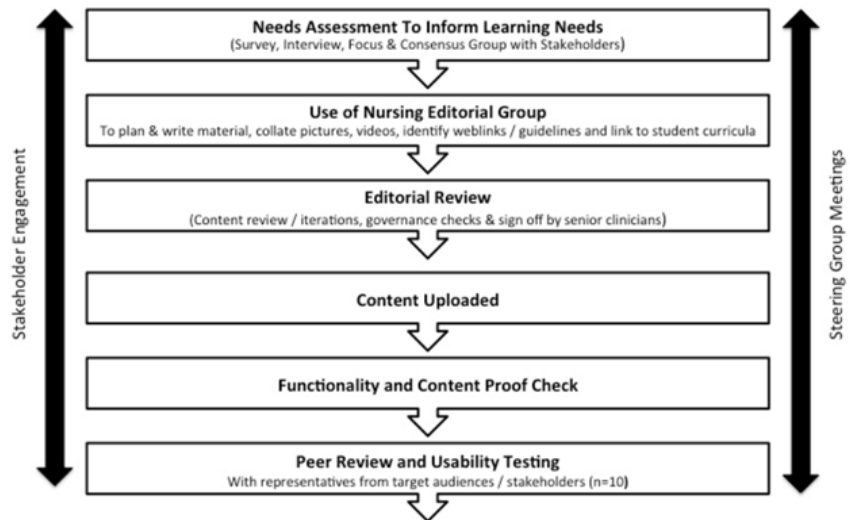
Figure 1. PMM Nursing Development Process.